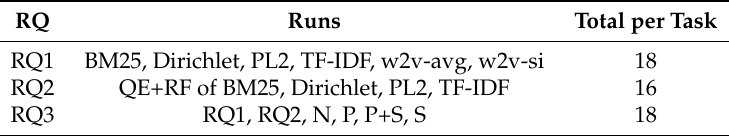
Table 2. Summary of all the runs analyzed per research